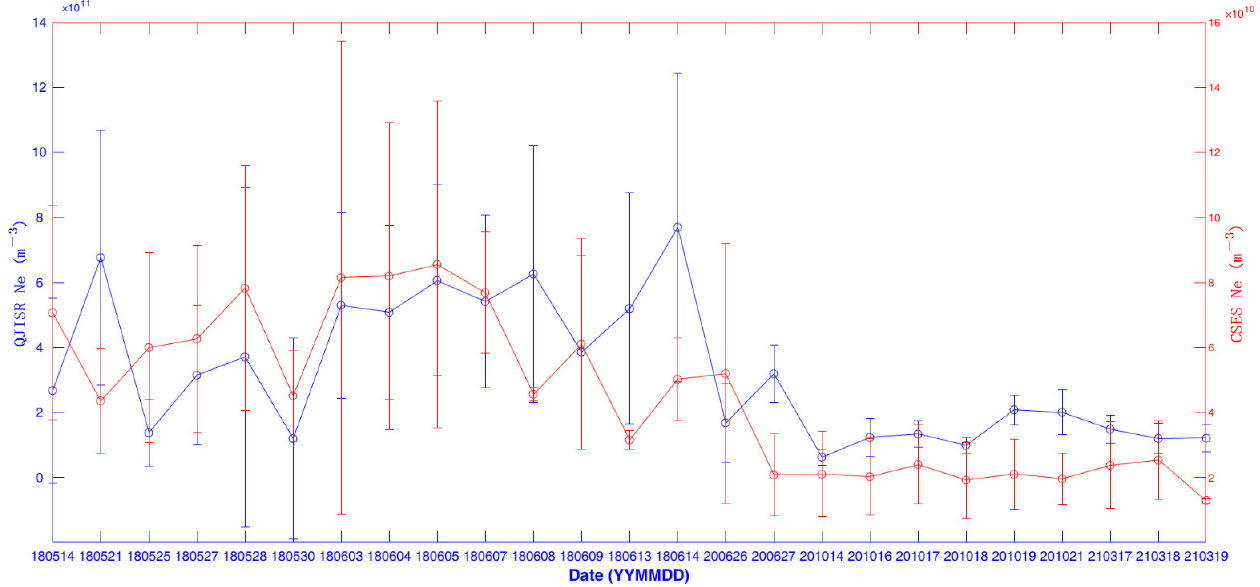
Figure 2. Ne time series for CSES (red line) and QJISR (blue line). Each day, the circle means mean value, and the bar represents standard deviation. The two time series are displayed with different amplitude scales to better underline their own variations. The comparison days are not continuous and the detailed dates are marked on the X axis.